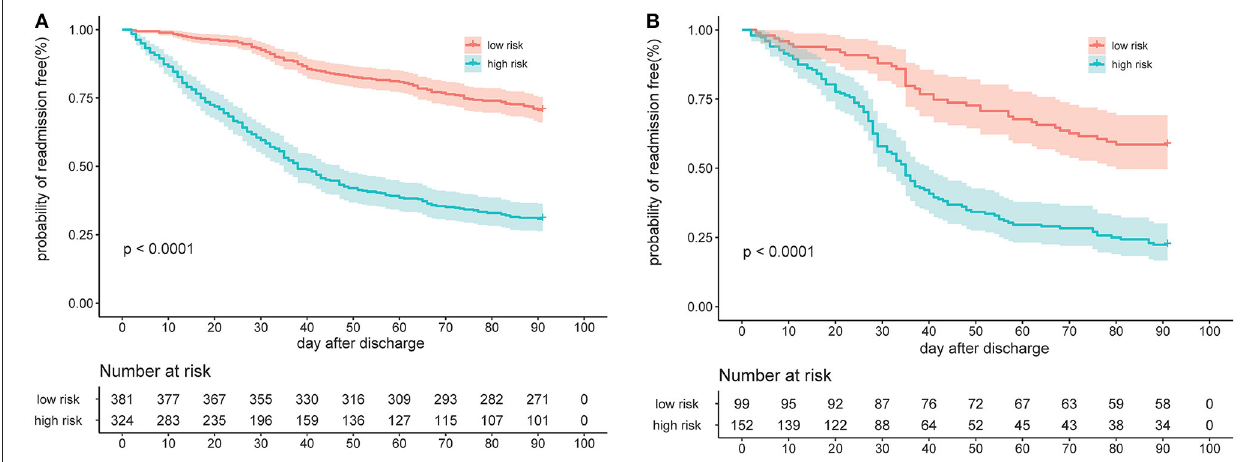
FIGURE 5 | Risk group stratification according to bisection of the nomogram predicted readmission in the derivation cohort (A) and the temporal validation cohort (B)